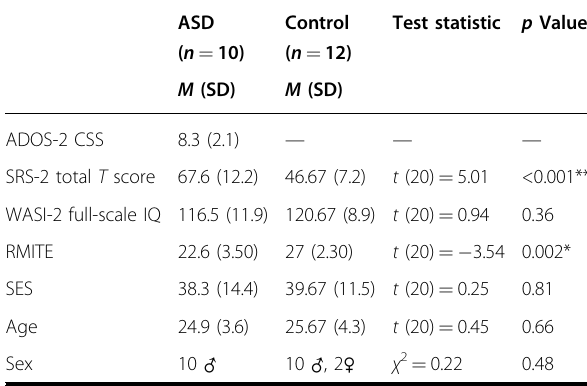
Table 1 Participant